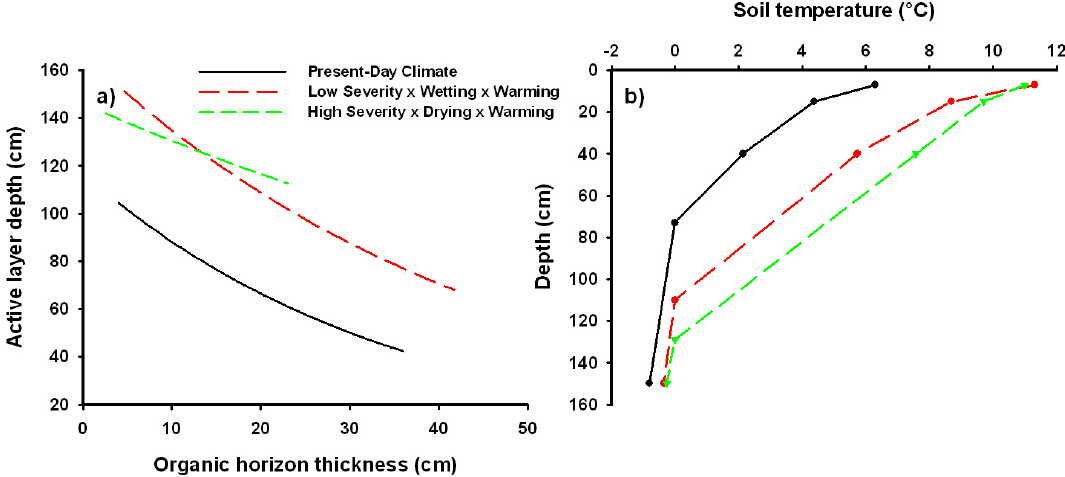
Fig. 6. Sensitivity of ALD (a) and mean monthly soil temperature in August (b) to multiple interacting factors. Using the GIPL model, we tested the effects of low fire severity, wetter soil conditions and warmer air temperatures (A2 scenario), high fire severity, drier soil conditions and warmer air temperatures, and changes in snow seasonality (following Euskirchen et al., 2009) associated with future warming (A2